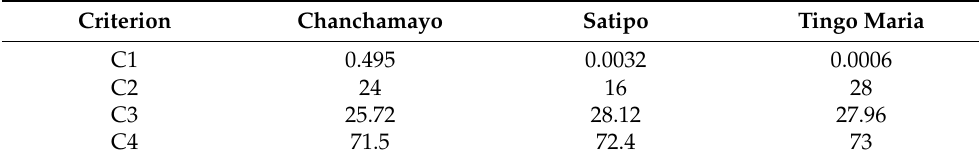
Table 3. Actual sampling data.